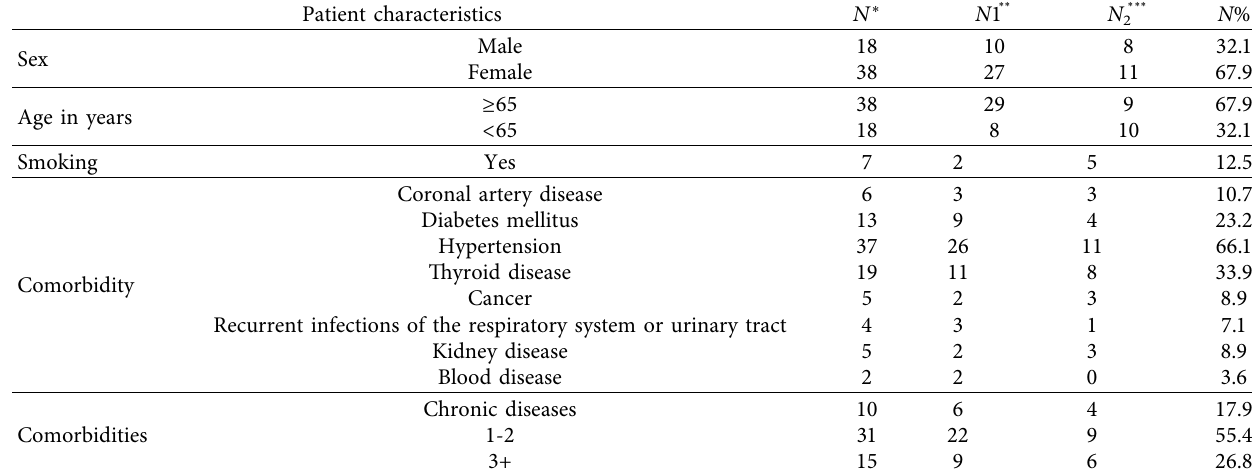
Table 1: Baseline demographic characteristics of the patients enrolled in our study. Patient